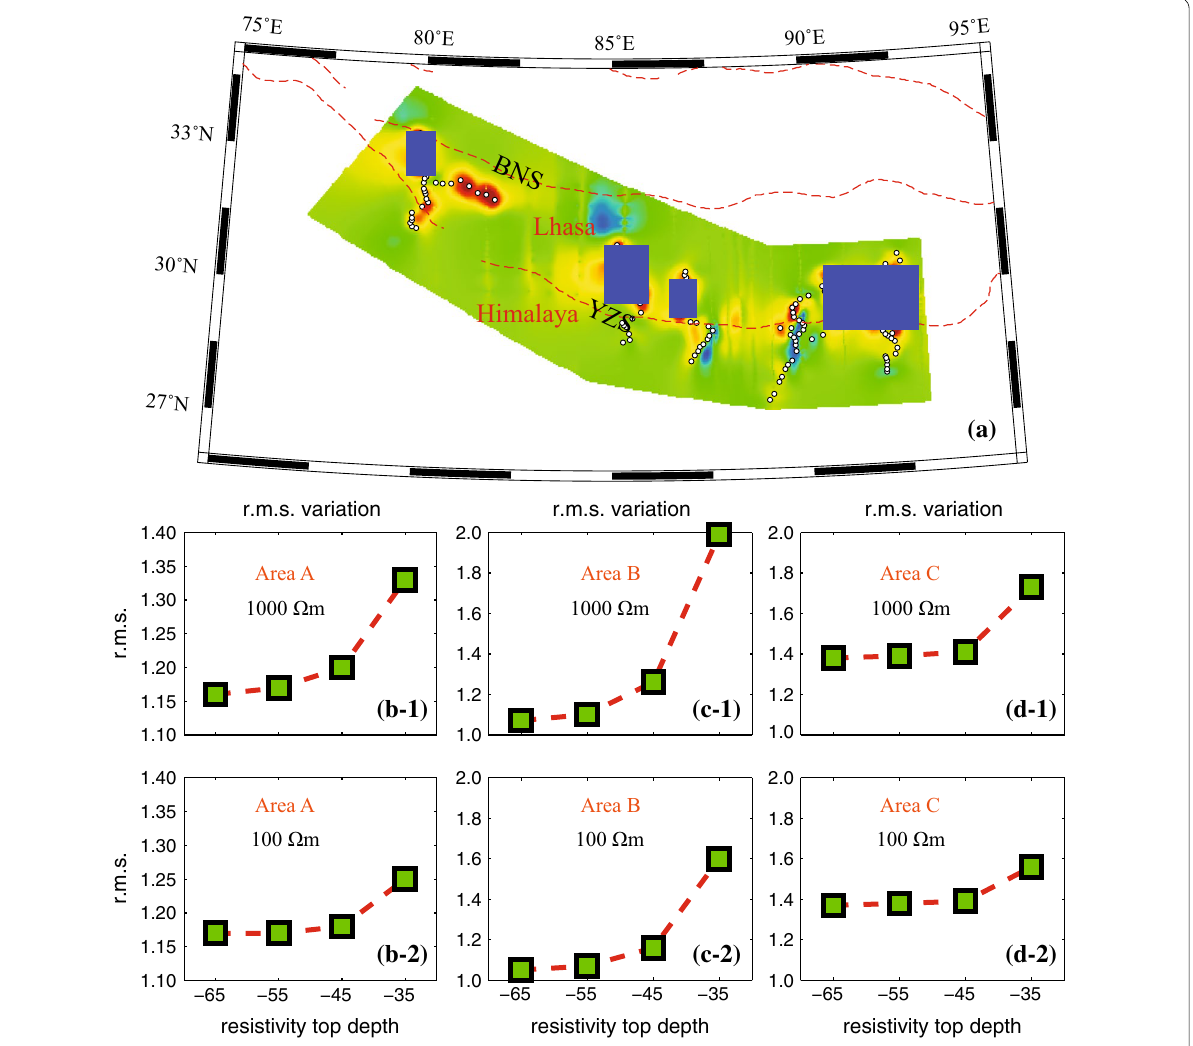
Fig. 8 Resolution tests for the downward extension depths of conductive zones in the 3D model. a The blue blocks mark the resistivity bodies that are set with different top depths. The dashed red lines show the YZS and BNS. b – d The r.m.s. misfit variation with the different top depths of resistiv- ity bodies of the area A, B, and C, respectively. b-1 , c-1 , d-1 Indicate the results from 1000 Ωm resistive blocks while ( b-2 , c-2 , d-2 ) from 100 Ωm resistive blocks. The r.m.s. is calculated only from the sites located in the blue blocks. The 3D forward modeling is performed for areas A, B, and C